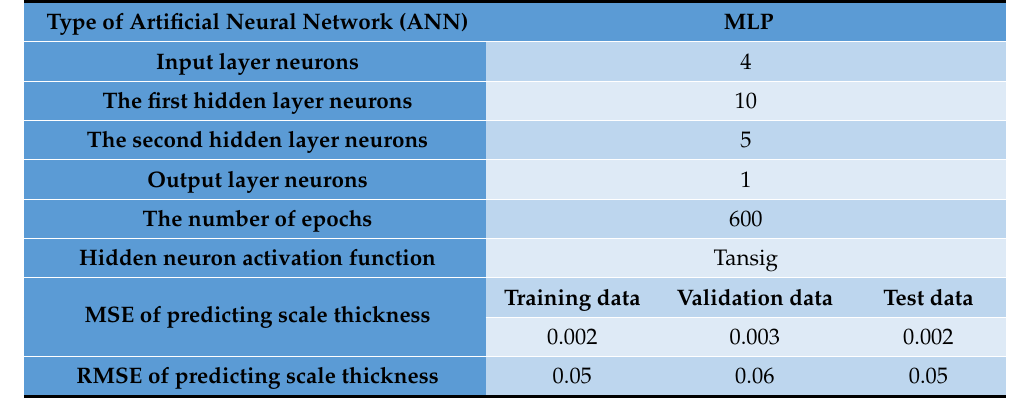
Table 2. A comparison of the accuracy of previous studies and the proposed detection system.